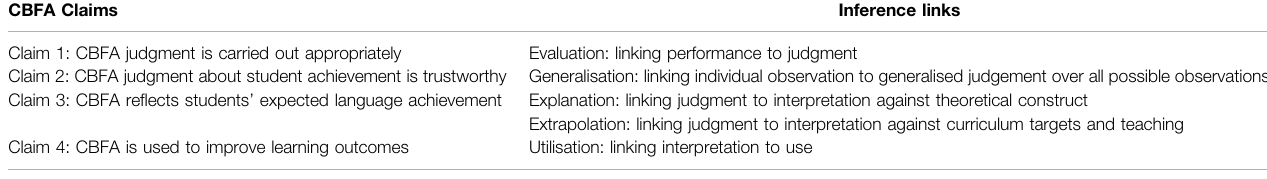
TABLE 2 | Claims and inferences in